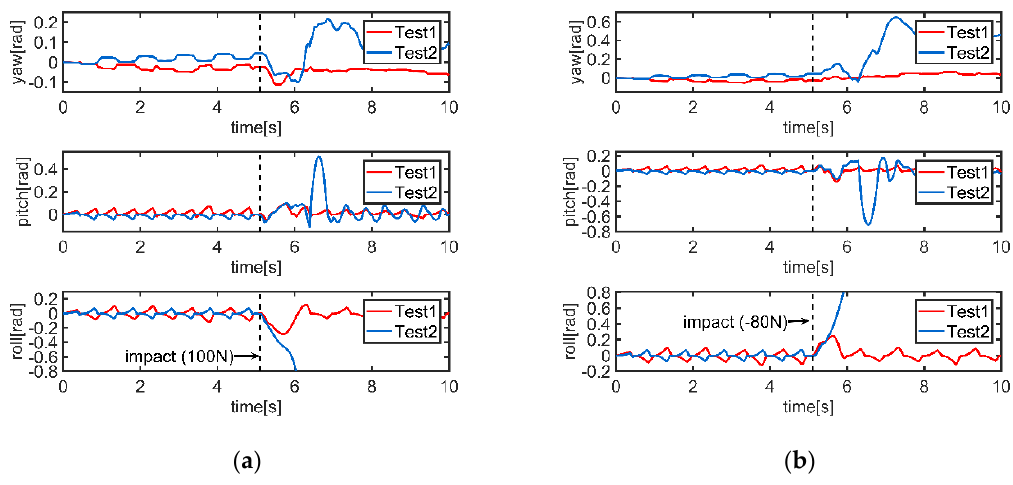
Figure 22. Posture angles of the two tests with impact forces: ( a ) 100 N; and ( b ) −80 N.